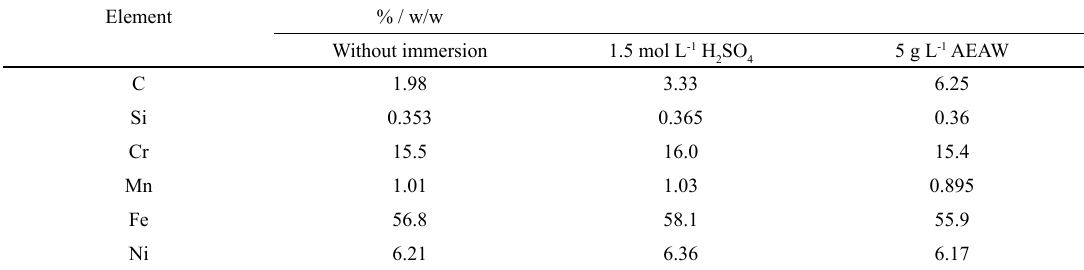
Table 4. Elementary composition of AISI 304 stainless steel samples after immersion in H obtained by EDS. Element